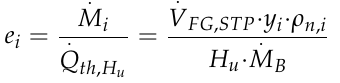
x Al 2 2 O 3 kg/kg,